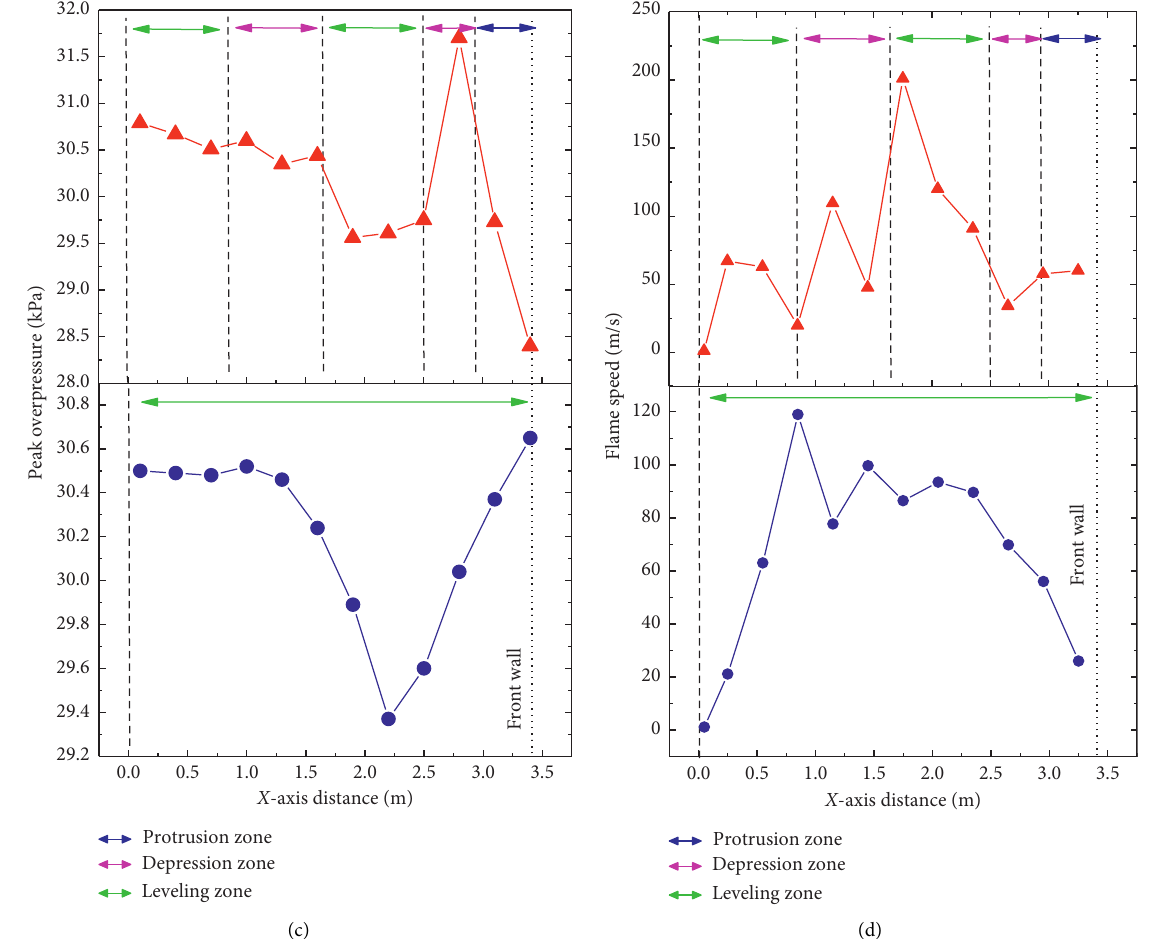
Figure 16: The variation law of (a) peak combustion rate and (b) its arrival time, (c) overpressure time curve, and (d) flame speed of configurations 3 (bottom) and 5 (top) on the z � 2m